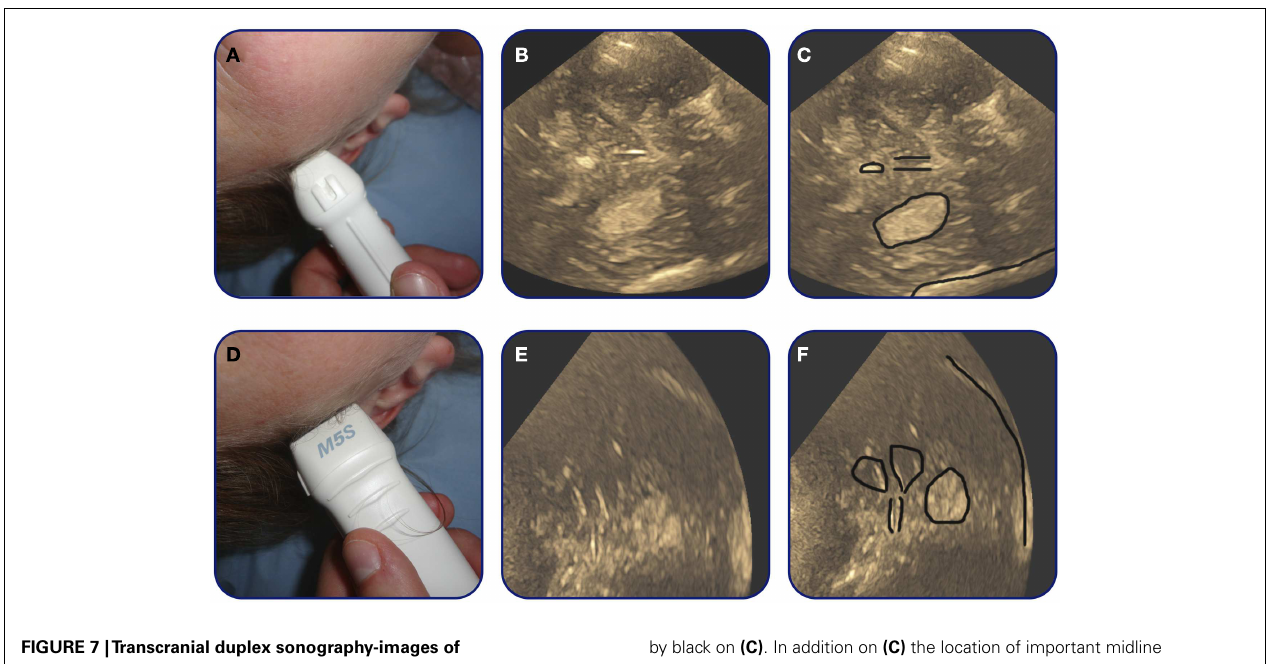
FIGURE 7 |Transcranial duplex sonography-images of basal-ganglia hemorrhage . A patient with basal-ganglia ICH. On axial images (A,B) the hematoma can be observed as a hyperechogenic region in the middle of the picture.The rim of the hematoma is marked